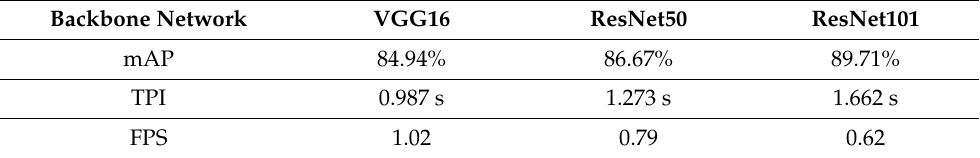
Table 1. The comparison for the mAP, TPI and FPS of three different backbone